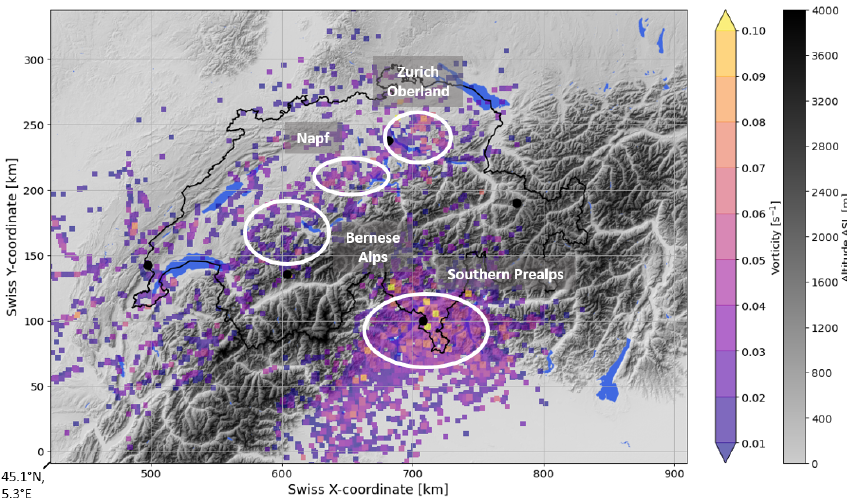
Figure 4. Maximum detected vorticity per 25km 2 during 5 years (2016–2020).